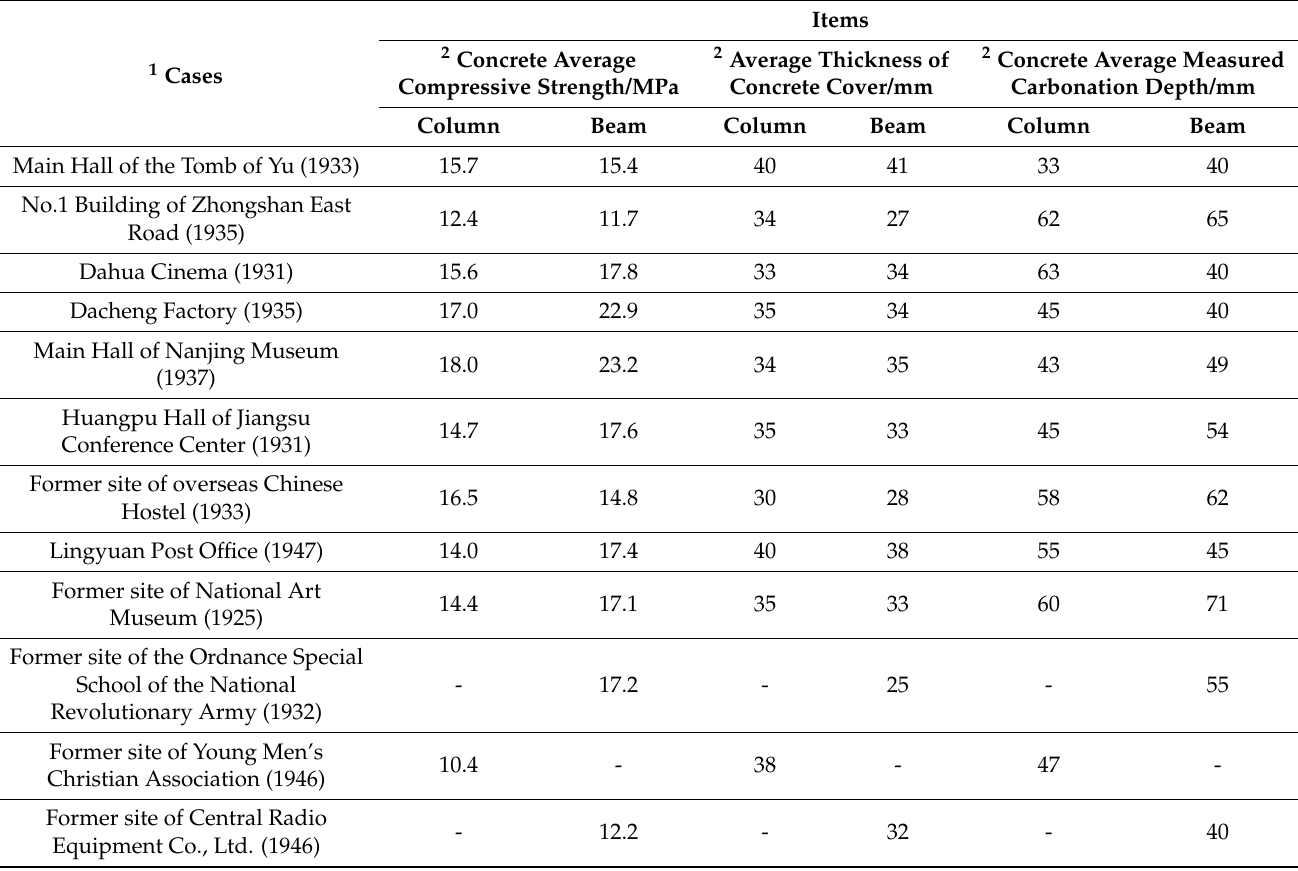
Table 2. The measured concrete material properties of some typical historical square rebar reinforced concrete